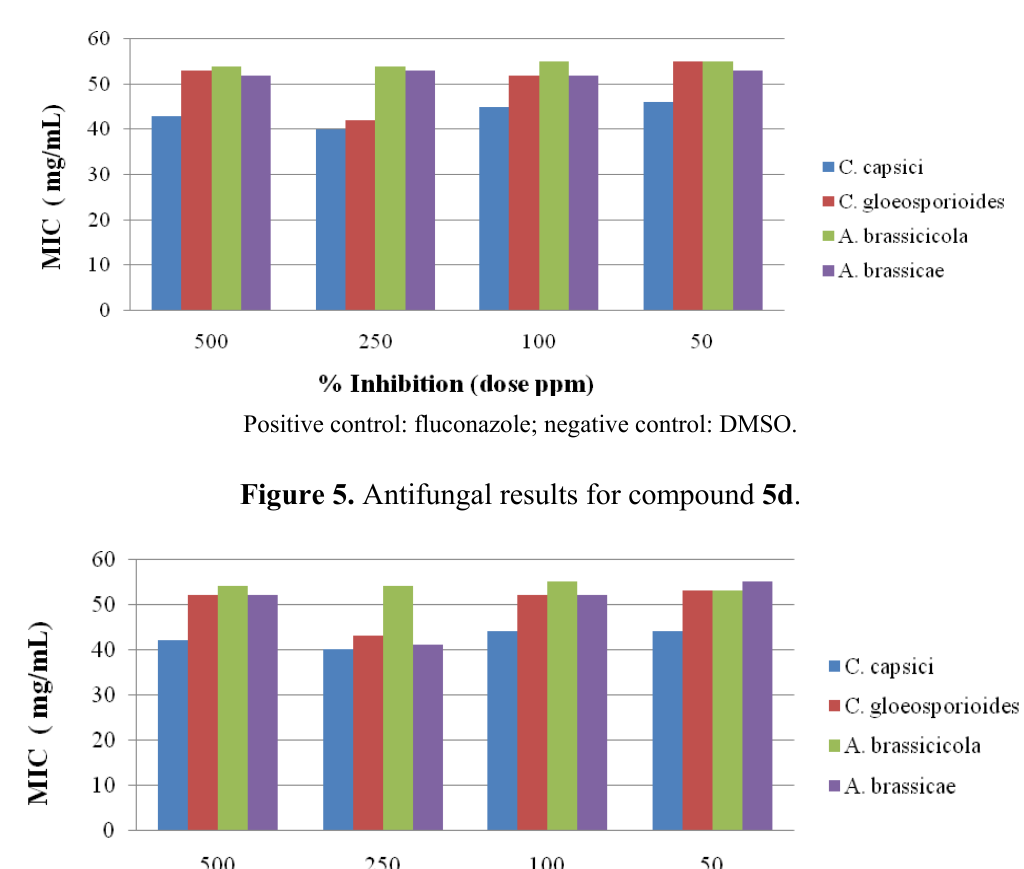
Positive control: fluconazole; negative control: DMSO. Figure 4. Antifungal results for compound 5c .